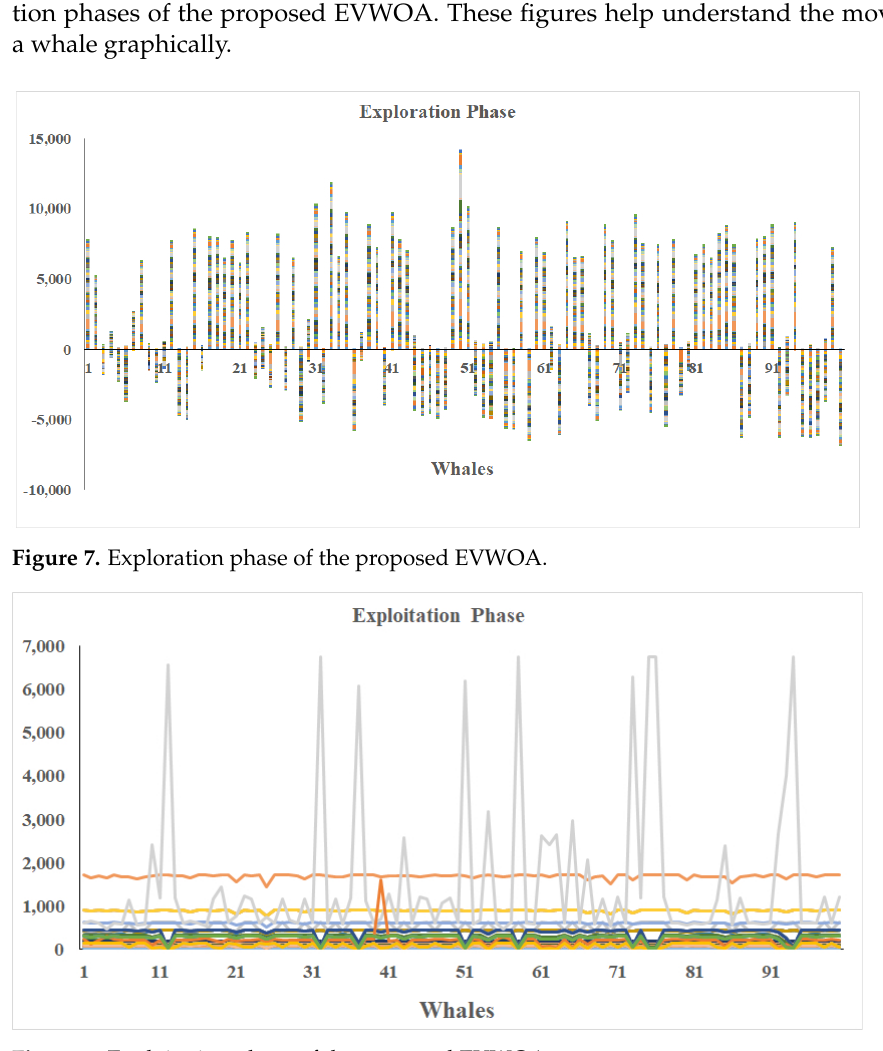
Figure 8. Exploitation phase of the proposed